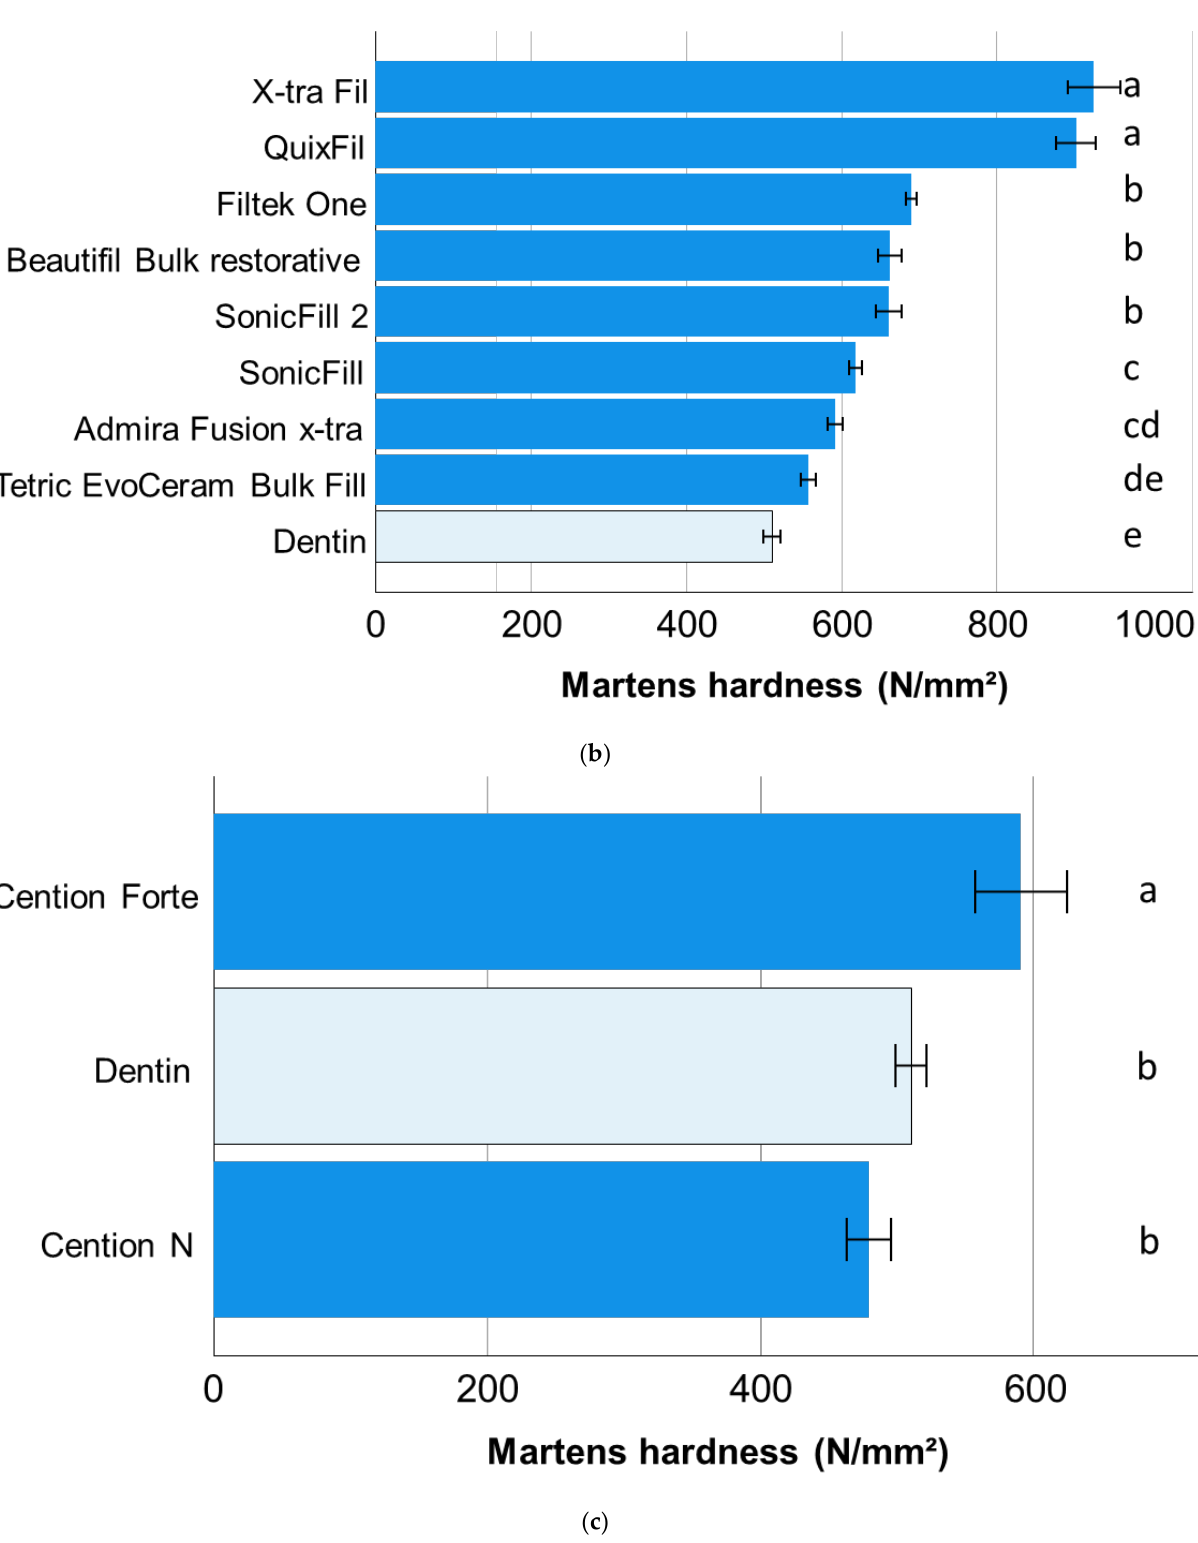
Figure 1. Martens hardness (means with 95% confidence interval) as a function of RBC and bulk-fill category: ( a ) light-cured, low-viscosity bulk-fill RBCs; ( b ) light-cured, high-viscosity bulk-fill RBCs; and ( c ) dual-cured bulk-fill RBCs. Letters indicate homogeneous groups within each material category; Tukey ’ s post-hoc test ( α = 0 .05).